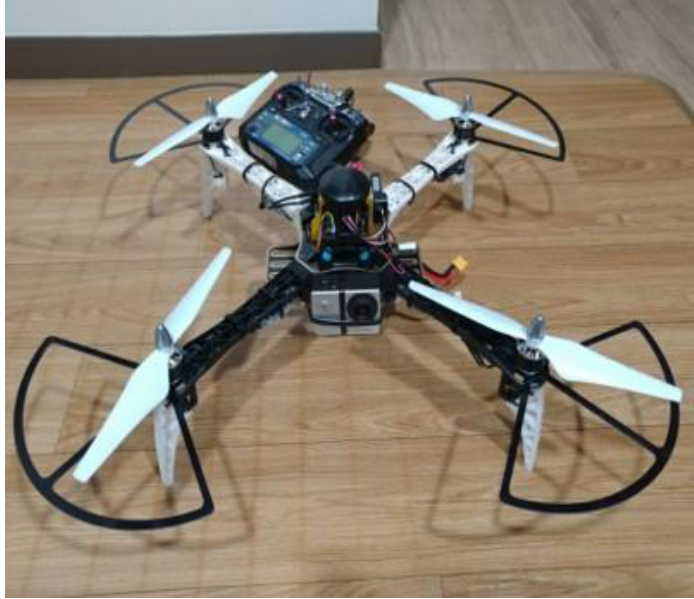
Figure 3. The drone equipped with the battery, video camcorder, propeller gears, and landing gears.